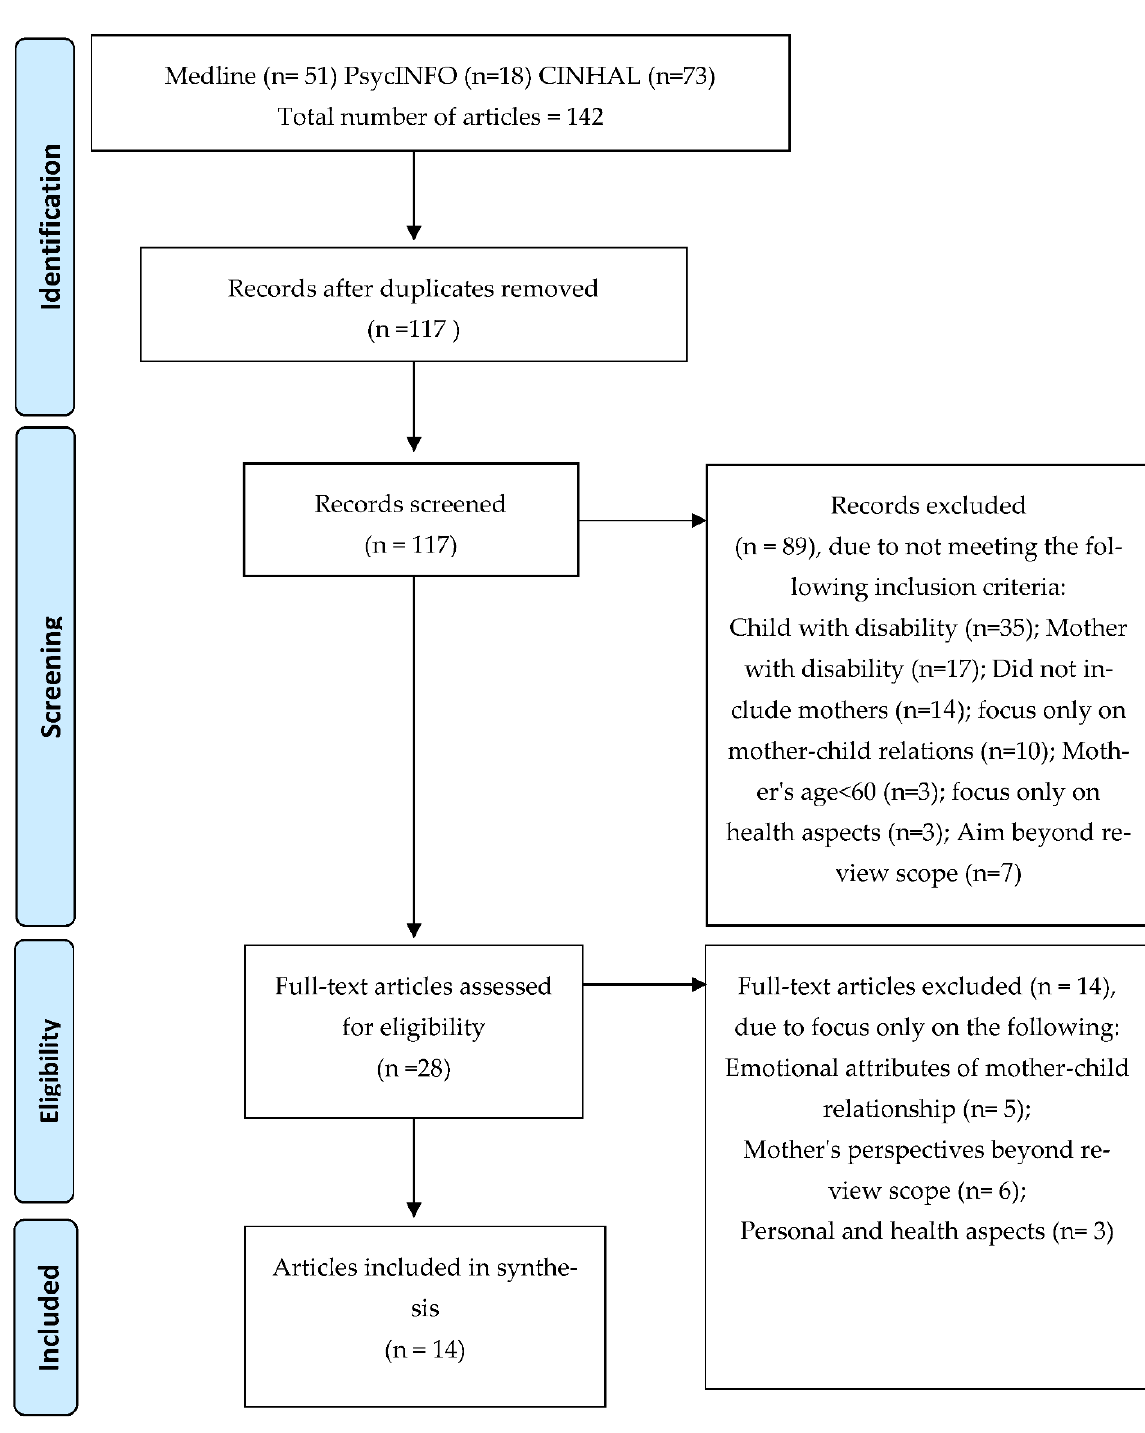
Figure 1. PRISMA diagram presenting systematic search process.